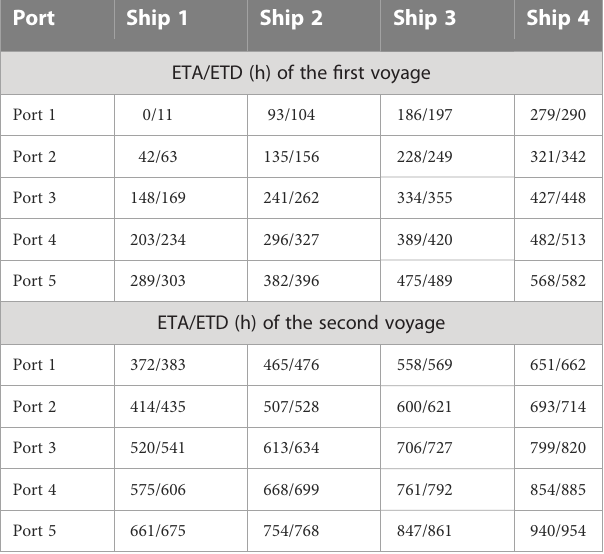
TABLE 8 ETA/ETD in the ideal situation.